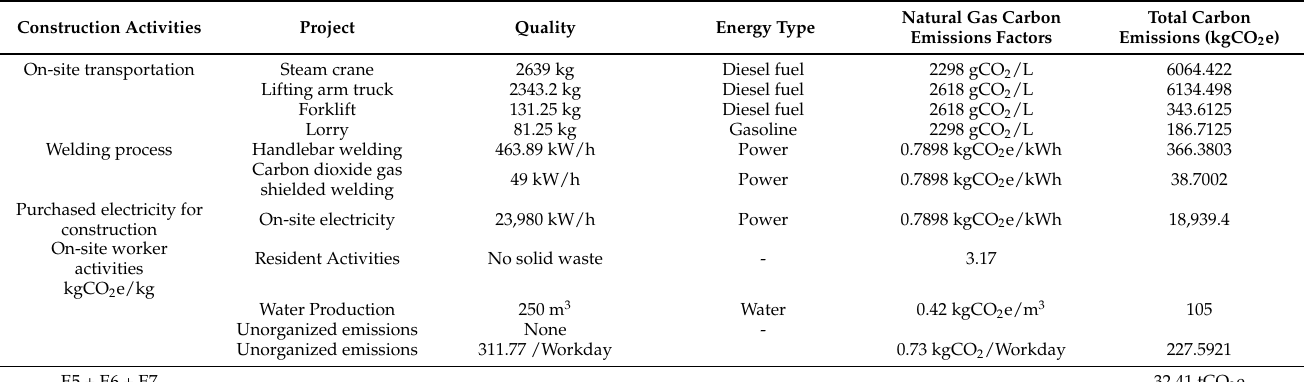
Table 16. Calculation of carbon emissions by site